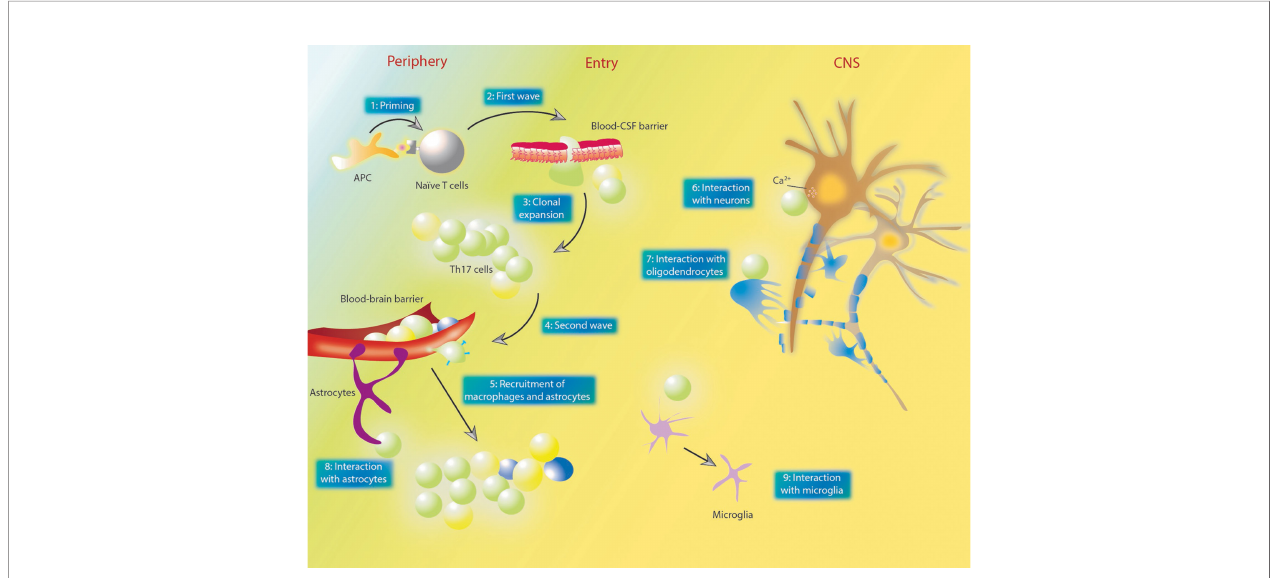
FIGURE 3 | The two-wave theory of MS pathogenesis and the interactions between Th17 and other cells. (1) in the priming process, naïve T cells in the periphery become antigen-speci fi c memory T cells. (2) those T cells in fi ltrate the blood-CSF barrier located in the choroid plexus. (3) after entering the subarachnoid space, Th17 cells undergo clonal expansion. (4, 5) the second wave denotes the activation of the BBB and recruitment of perivascular leukocytes. Plasma membrane molecules such as CCR6, CD6 and CD49d enables Th17 cells to cross BBB endothelium. Dendritic cells and macrophages could be recruited by GM-CSF secreted by Th17 cells. (6) Th17 cells contact neuron directly and lead to neuron damage via affecting intra-neuron Ca 2+ concentrations. (7) Th17 cells could damage oligodendrocytes through direct contact or increased oxidative stress. (8, 9) various studies also demonstrated the effect of Th17 cells and their cytokines on astrocytes and neurons. GM-CSF could directly act on astrocytes and promote their recruitment. MS, multiple sclerosis; Th, T helper; CSF, cerebrospinal fl uid; BBB, blood brain barrier; GM-CSF, granulocyte-macrophage colony-stimulating factor; APC, antigen-presenting cells; CNS, central nervous system.